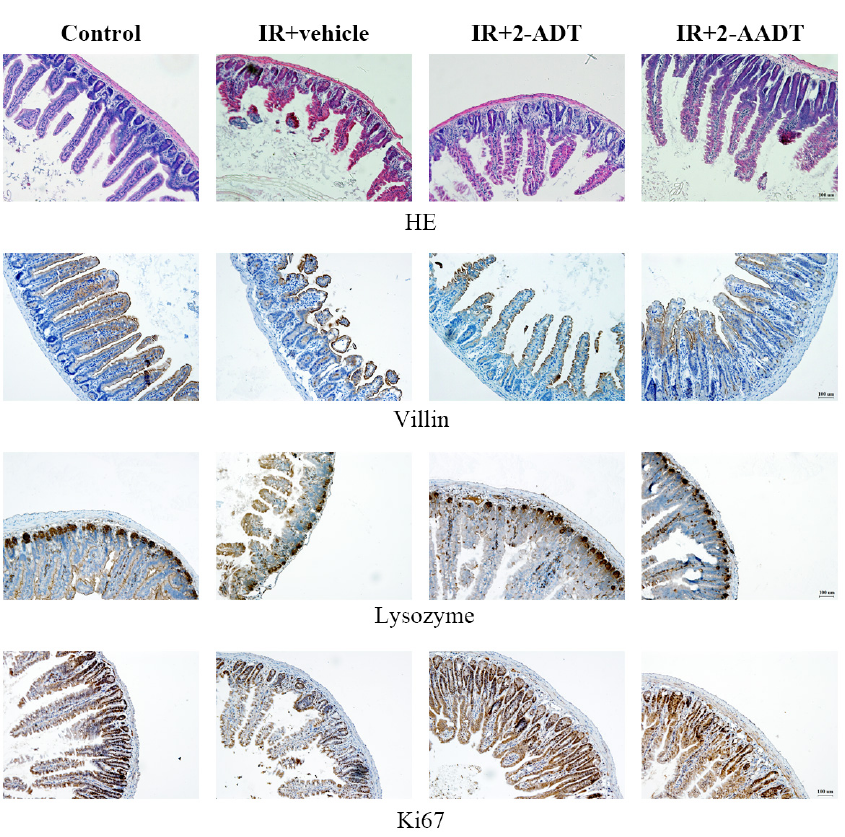
Figure 6. Effects of 2-ADT and 2-AADT on intestinal injury in mice after 13 Gy abdominal irradiation. 2-ADT and 2-AADT were administered i.p. 30 min before irradiation.the small intestine of mice was harvested 3 days after abdominal irradiation for pathological and immunohistochemical examination. Representative HE staining and imunohistochemical images of villin, lysozyme and Ki67 of the small intestine in different treatment groups. Scale bar, 100 µ